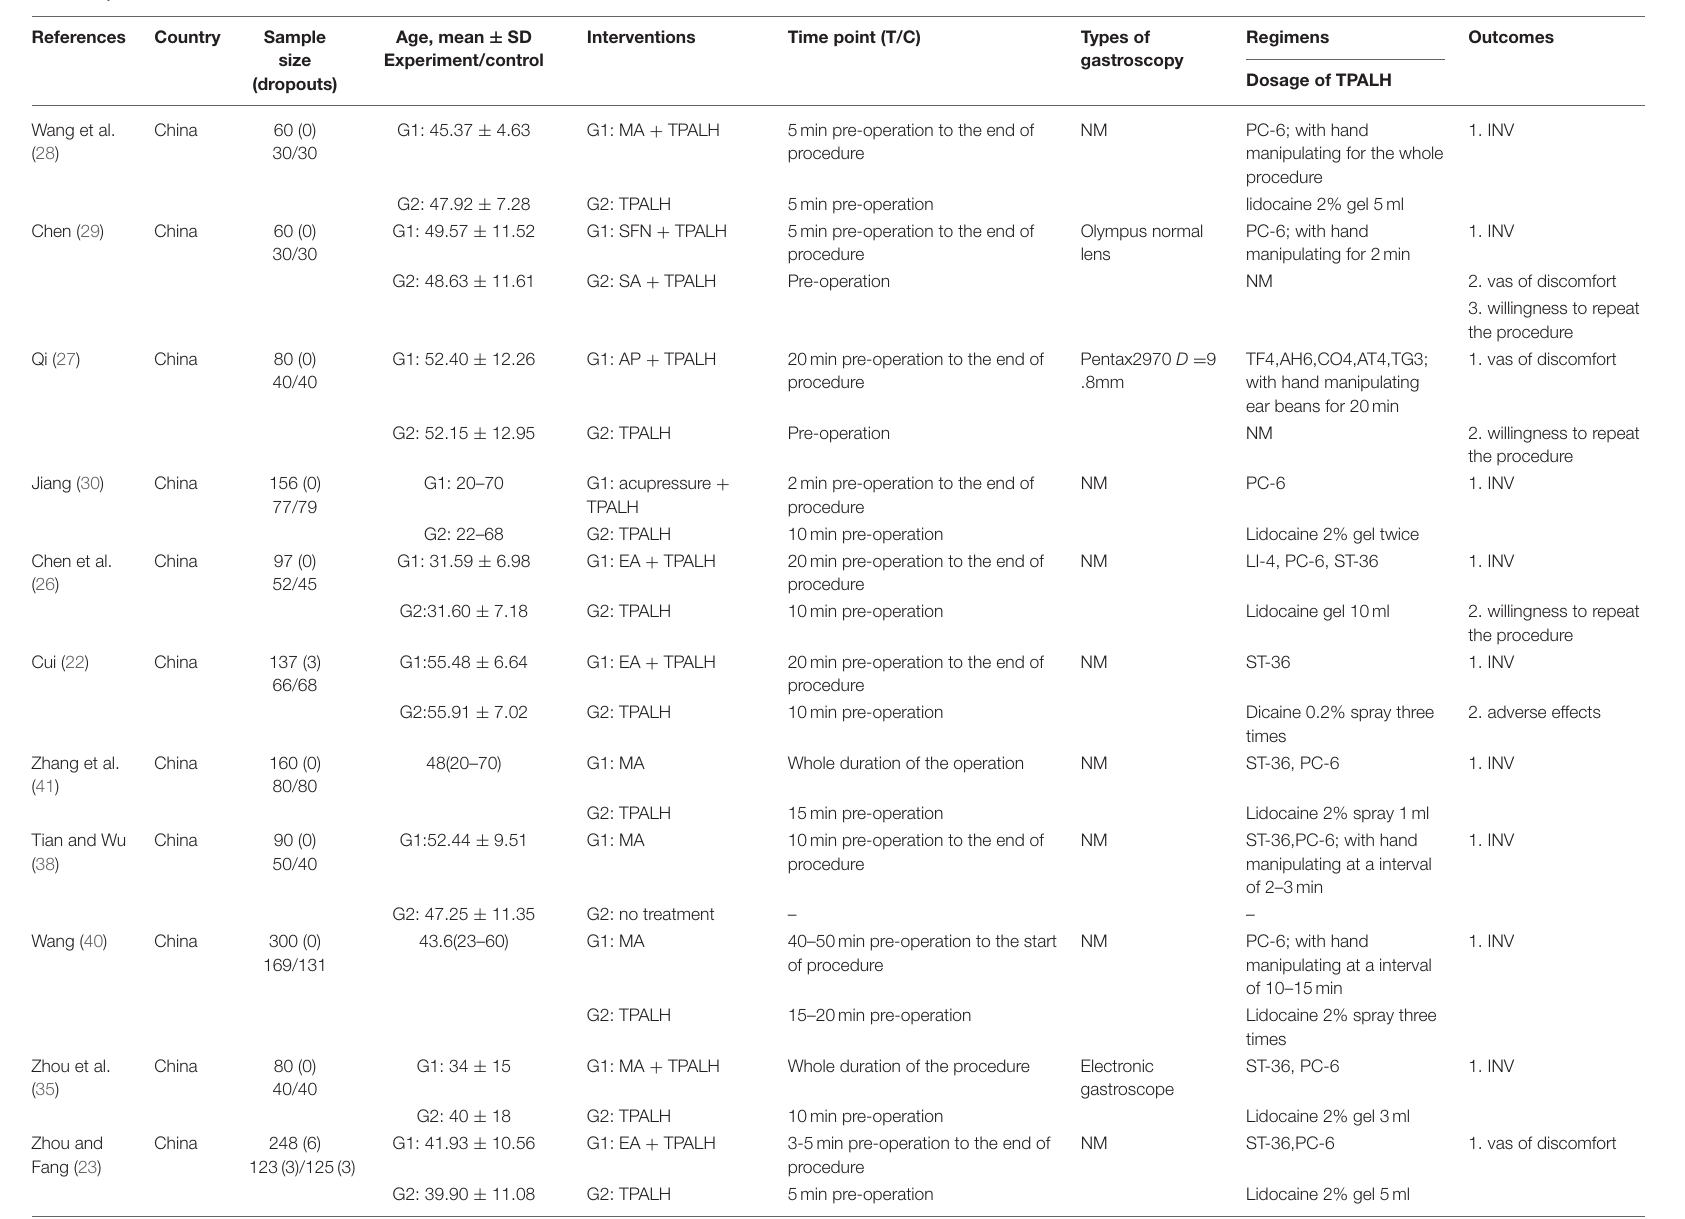
TABLE 1 | Characteristics of included